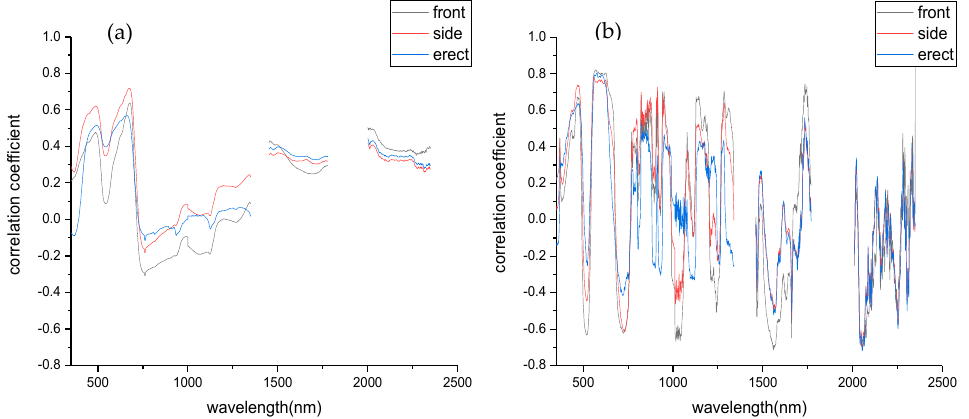
Figure 5. Correlation coefficient curves of different spectra and severity of disease. ( a ) The original spectrum. ( b ) First order derivative spectrum.